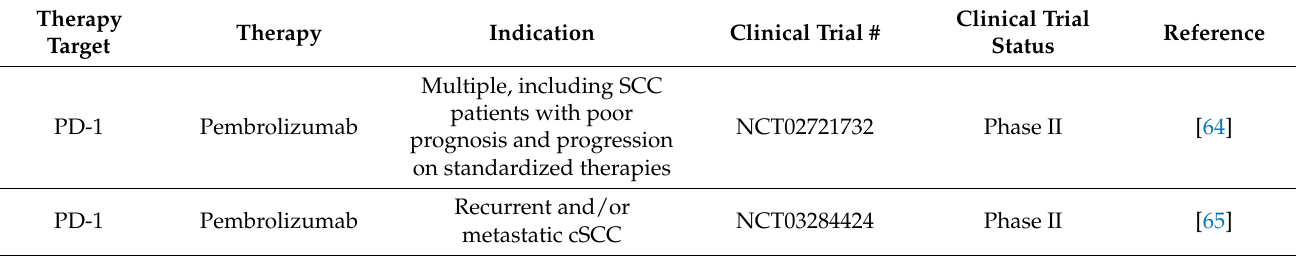
Table 1. Clinical trials 1 for antibodies directed against PD-1/PD-L1, CD137, VISTA in cutaneous SCC.